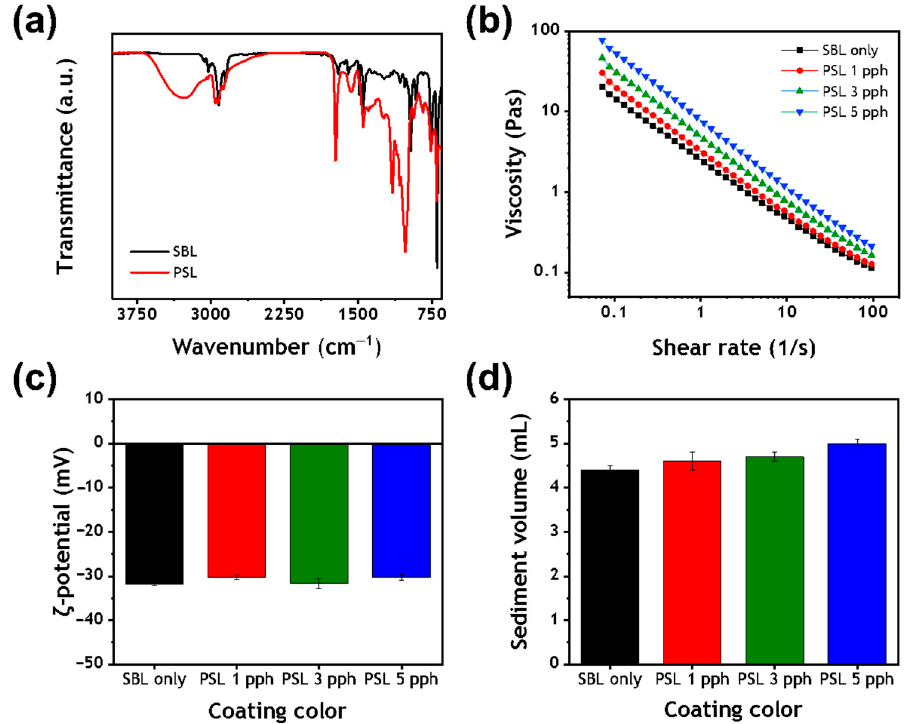
Figure 3. ( a ) Fourier transform infrared spectra of styrene/butadiene (S/B) and polymer-stabilized (PS) latex films, ( b ) the effect of PS latex dosage on the viscosity of coating color as a function of shear rate, ( c ) the zeta potential of coating colors, and ( d ) the sediment volume of coating